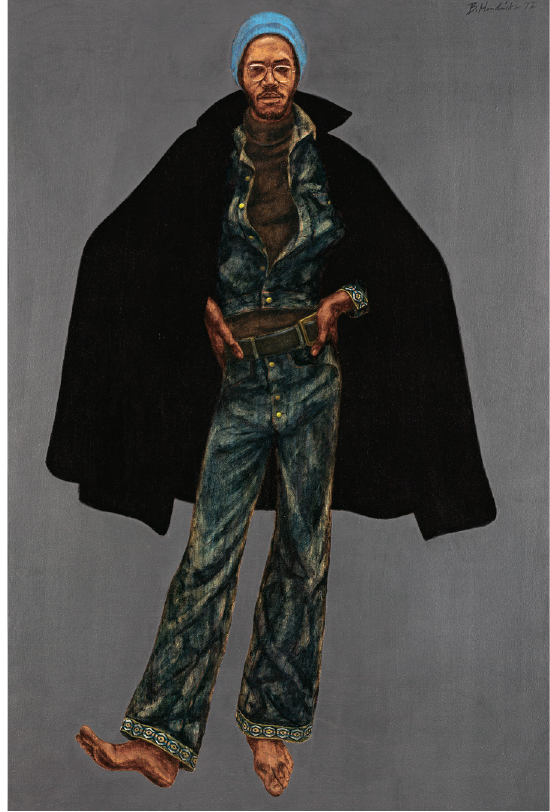
Figure 1. Hendricks, Barkley L., George Jules Taylor (1972). Oil on canvas, 91 7/16 x 60 ¼ in. ©Estate of Barkley L. Hendricks. Courtesy of Jack Shainman Gallery, New